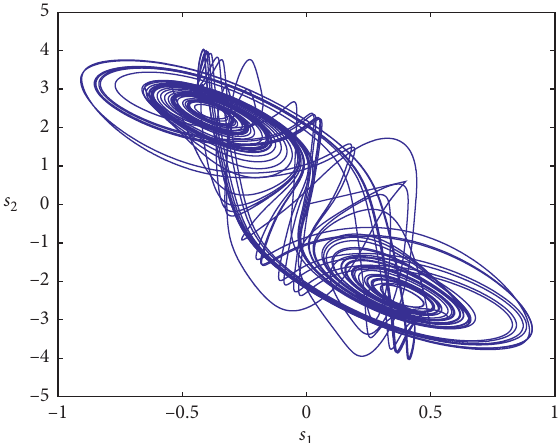
Figure 2: The phase plot of the leader for Example